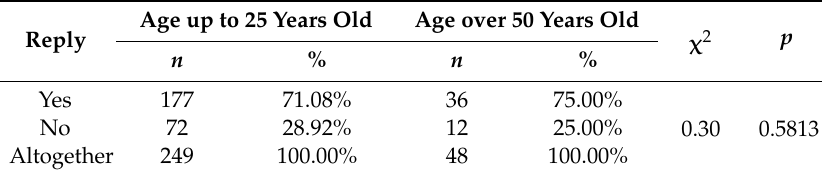
Table 12. Study about the motivation to undertake PA due to cheering in the 6th Poznan Half Marathon—depending on age.